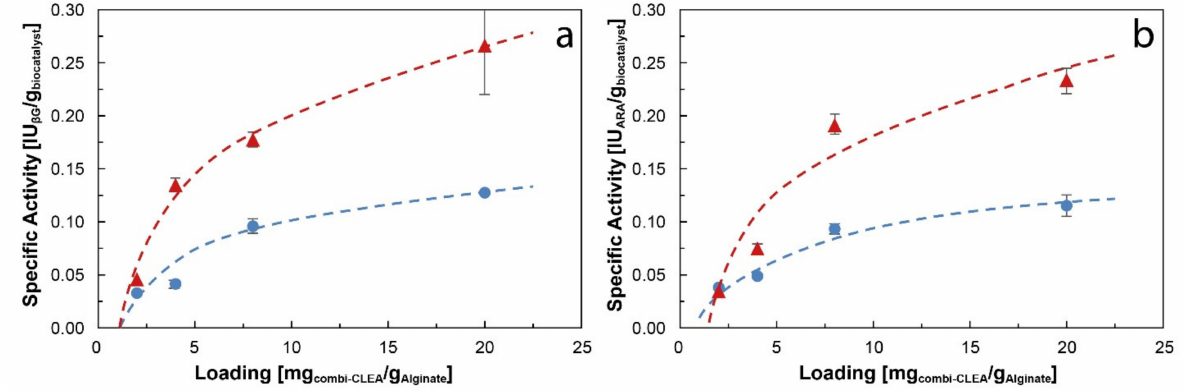
Figure 1. Effect of combi-CLEAs loading in alginate beads on the expressed specific activity of ( a ) β G and ( b ) ARA, in beads of two sizes: ( ) 2.8 mm average diameter and ( ) 4.2 mm average diameter. Results are presented as mean ± margin of error, n =